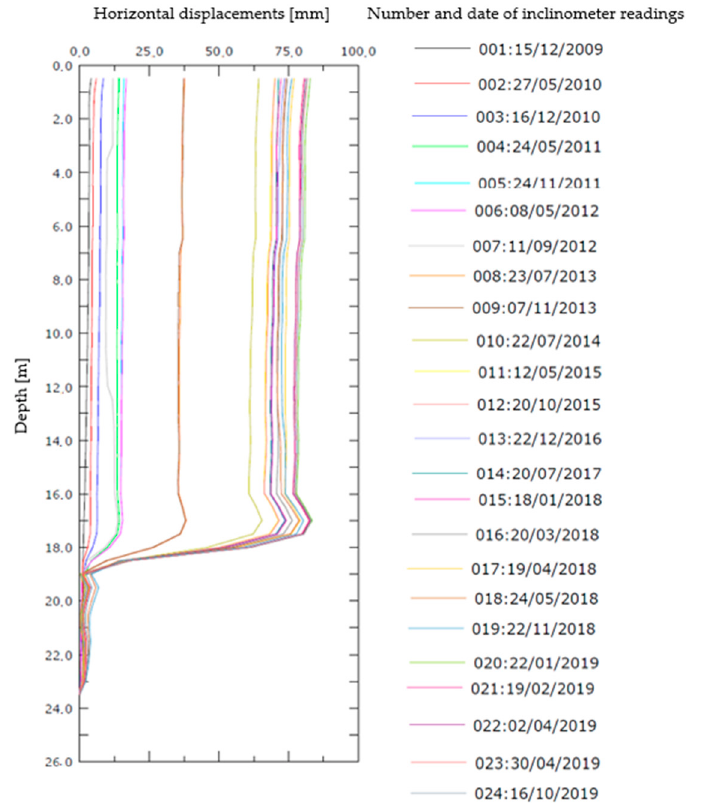
Figure 6. Inclinometer readings at I3 (source: ARPAL).